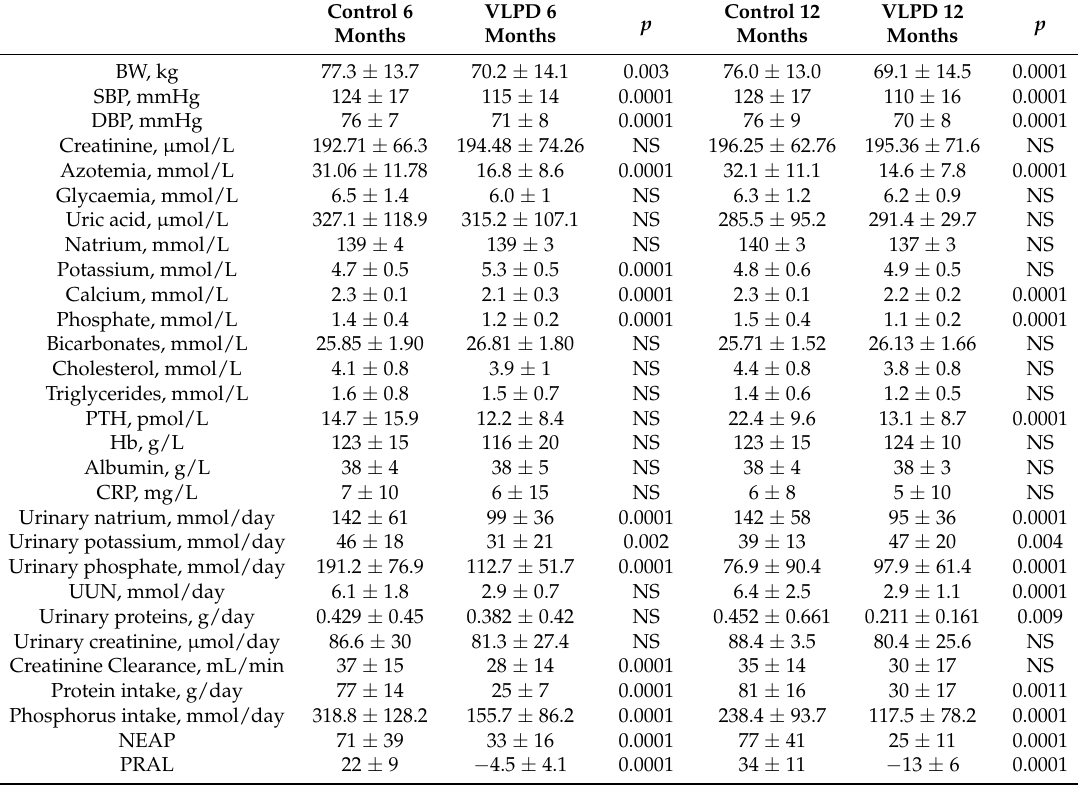
Table 3. Data at 6 and 12 months in control group and VLPD